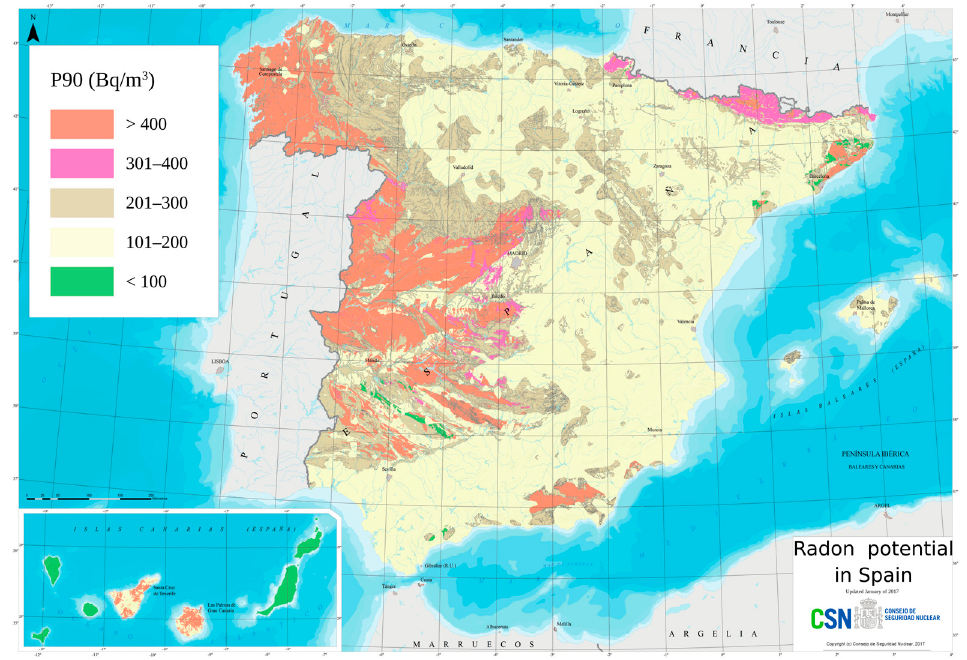
Figure 1. Map of radon potential in Spain (Nuclear Safety Council). Available at https://www.csn.es/mapa-del-potencial-de-radon-en-espana . The radon potential of an area is the 90th percentile (P90) of the radon distribution of buildings in an area. For example, P90 for a concentration of 300 Bq/m 3 indicates that 90% of buildings have concentrations below that threshold, while the remaining 10% exceeds them.